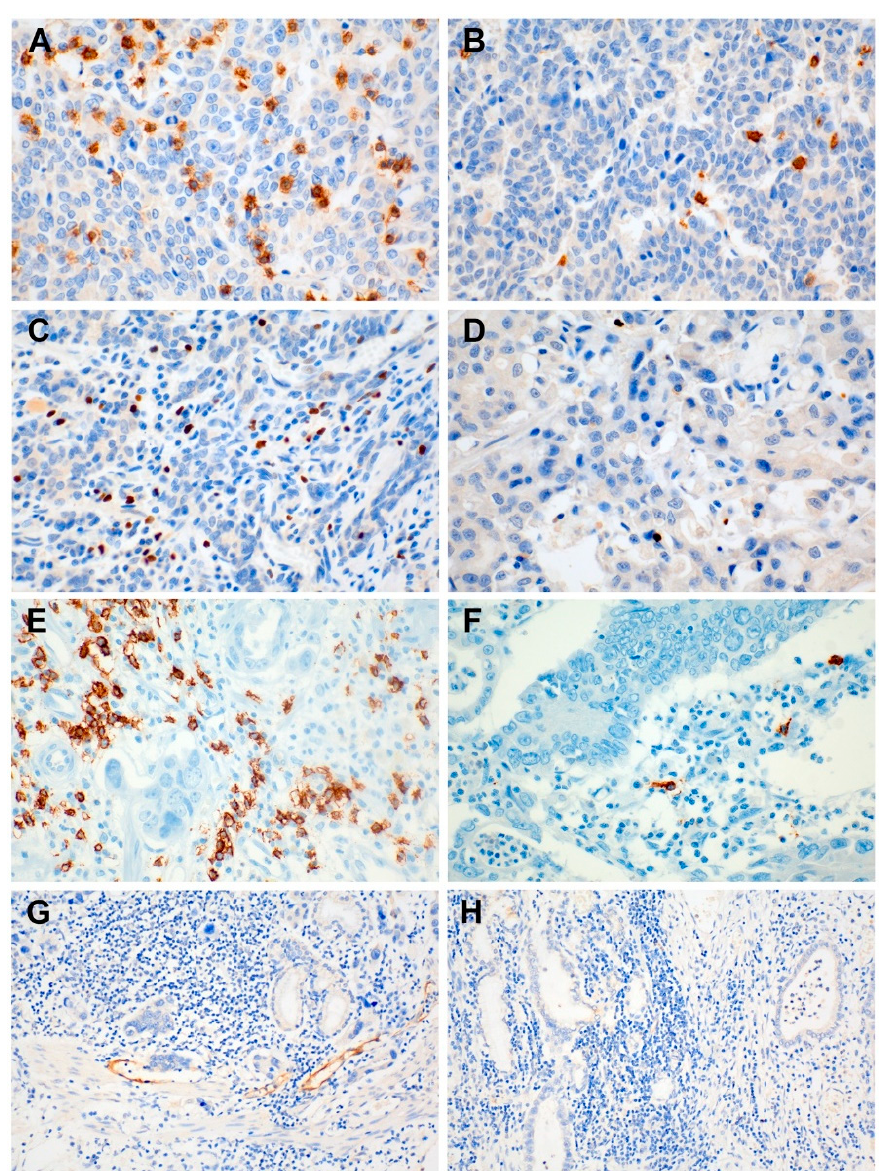
Figure 1. Representative immunohistochemistry of CD8 + tumor infiltrating lymphocytes (TILs), Foxp3 + TILs, and MECA-79 expression. ( A ) A high CD8 + TIL level, ( B ) a low CD8 + TIL level, ( C ) a high Foxp3 + TIL level, ( D ) a low Foxp3 + TIL level, ( E ) a high CD20 + TIL level, ( F ) a low CD20 + TIL level, and ( G ) a high endothelial venule (HEV) level exhibited by MECA-79; ( H ) no HEVs identified by MECA-79.